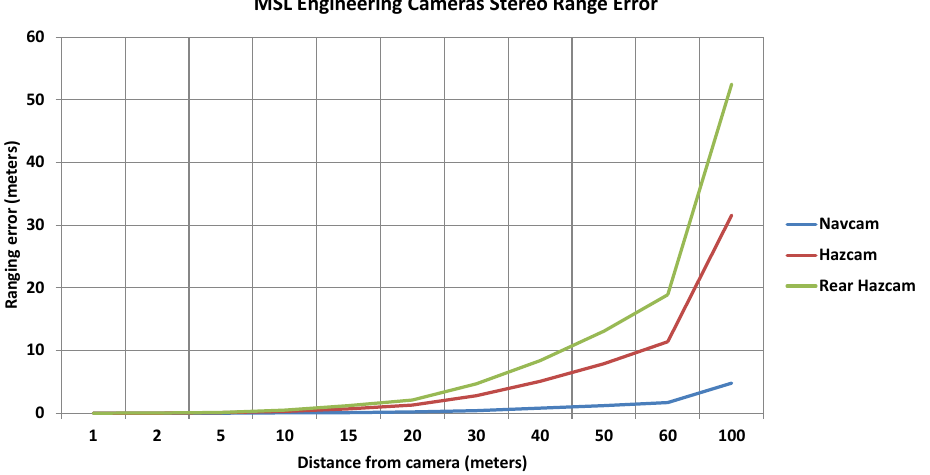
Figure 3. MSL engineering cameras stereo range error as a function of distance from the